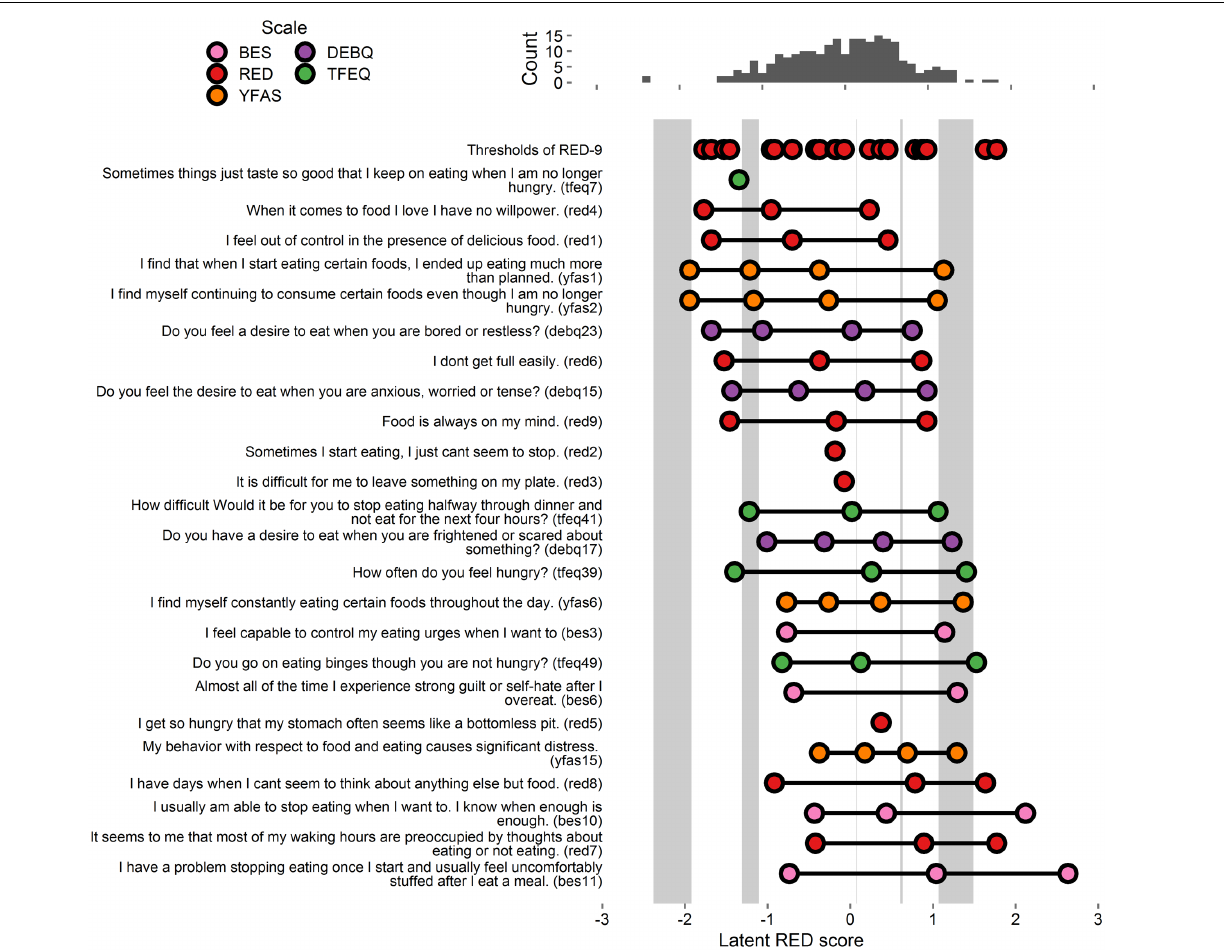
FIGURE 1 | Person-item map and histogram depicting thresholds on the spectrum of reward-related eating (RRE) for Study 1. The histogram at top displays the locations of participants on the latent RRE construct. The top row of the person-item map at bottom depicts the locations of the gaps in coverage of the RRE construct left by the RED-9. The 27 items listed below “thresholds of RED items” are ordered by the average of their thresholds’ values, and colored by the respective scale from which they originate. Circles depict each threshold, i.e., location on the RRE construct where people are most likely to move from one response option to the next. Gray rectangles appear whenever the gap between two consecutive RED-9 item thresholds is wider than 0.29 units. The gray rectangle only highlights parts of the latent trait that are further than 0.29/2 units from any RED-9 threshold. This figure includes the RED-9 items and all items that account for variance in the gap areas. See Supplementary Figure S1 for a figure with all items